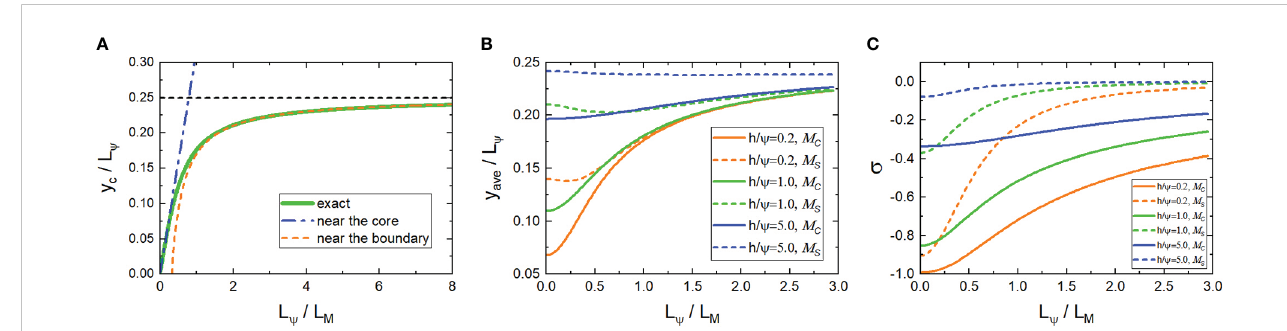
FIGURE 6 (A) The distance y c between the center of the waves and the core of the negative vorticity as a function of L y / L M , which is caused by the advection term. (B, C) y ave / L y (B) and s (C) vs L y / L M from the lowest eigenmodes of M C and M S with different h / Y =0.2,1,5,